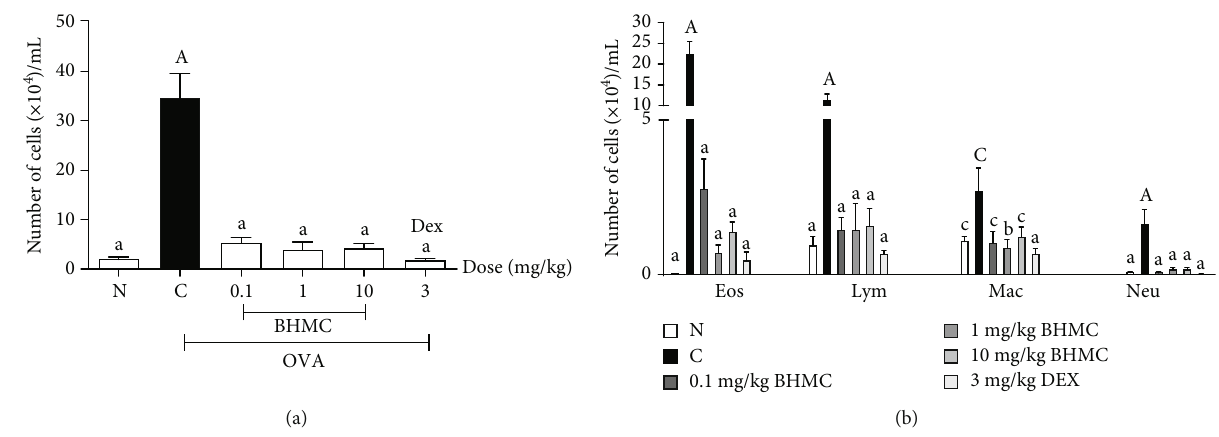
Figure 3: The e ff ects of BHMC on the (a) total leukocytes and (b) di ff erential cell counts in the BALF from OVA-induced mice. The BALF was collected from euthanized mice ( n = 8 per group), and the cells were stained with Wright stain. The numbers of leukocytes, eosinophils, neutrophils, lymphocytes, and macrophages were counted under the microscope. The values are expressed as mean ± SEM . c: P < 0 : 05 , b: P < 0 : 01 , and a: P < 0 : 005 , signi fi cantly di ff erent from the OVA group. C: P < 0 : 05 and A: P < 0 : 005 , signi fi cantly di ff erent from the N group. N represents the PBS group whereas C represents the OVA-challenged